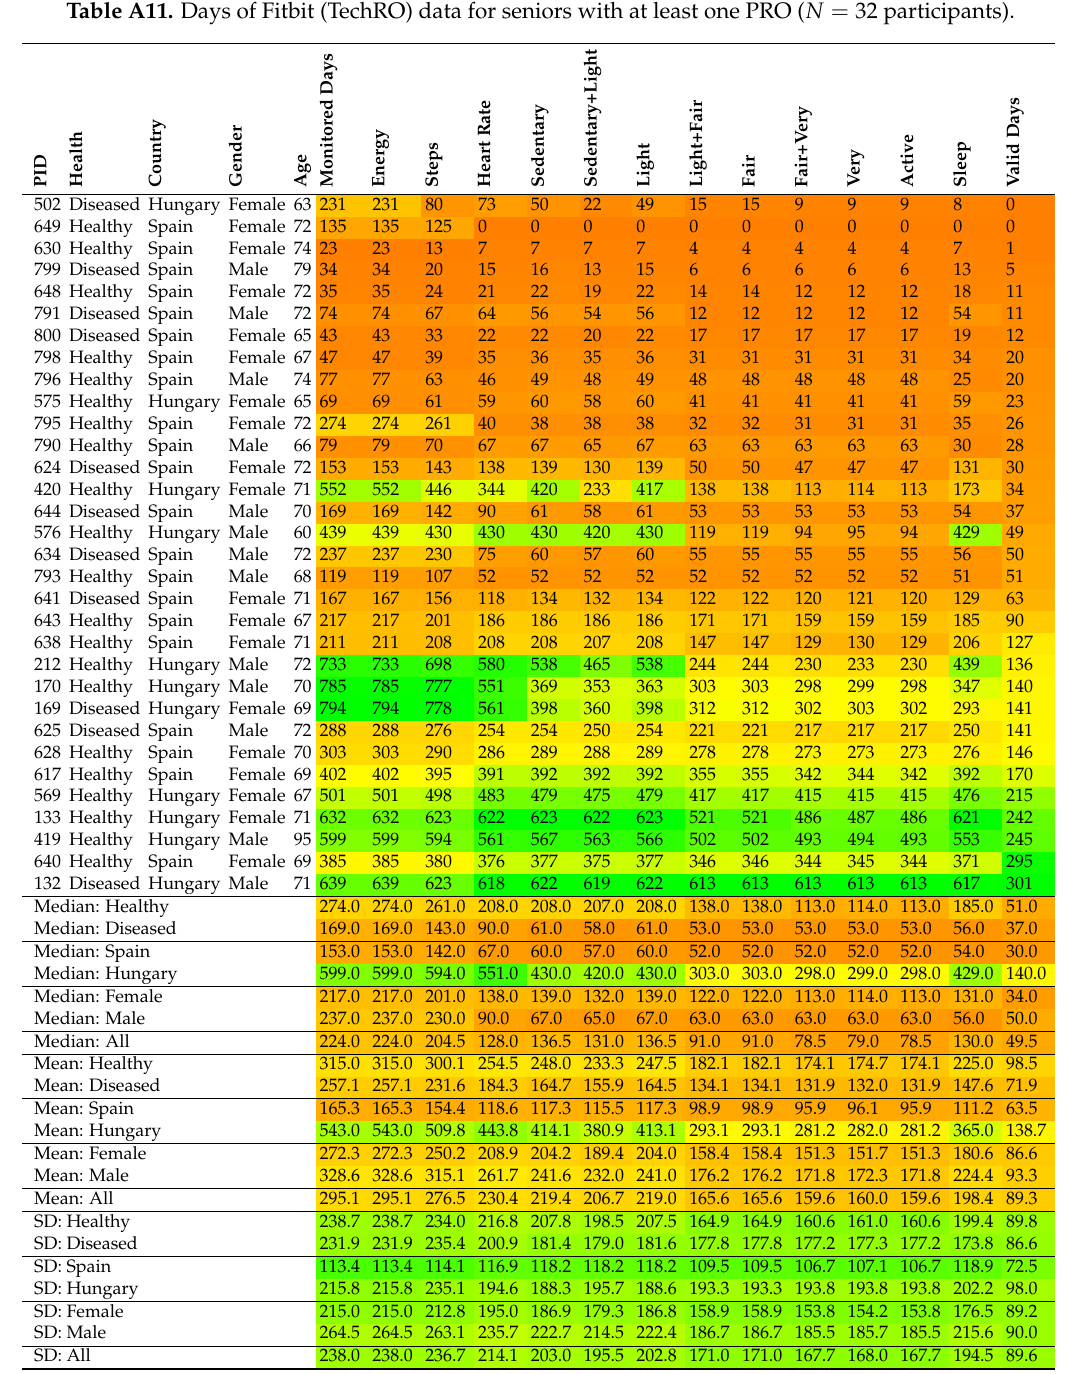
Table A11. Days of Fitbit (TechRO) data for seniors with at least one PRO ( N = 32 participants).